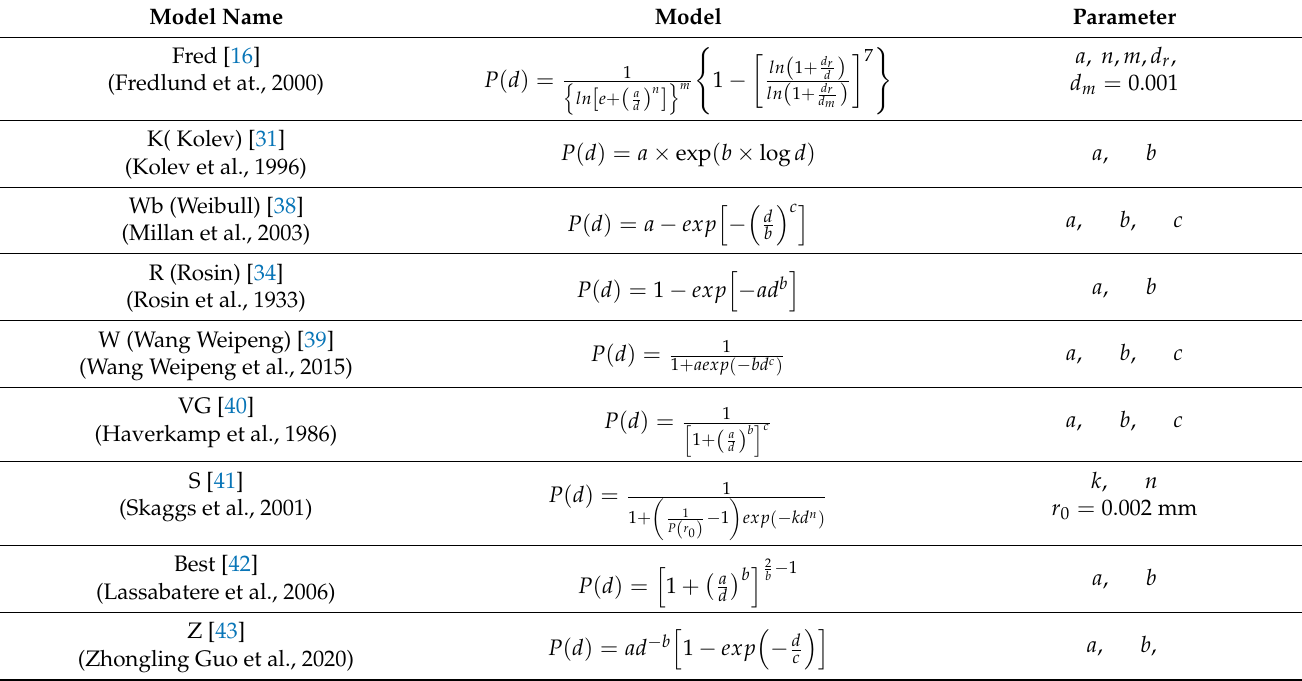
Table 2. Particle size distribution